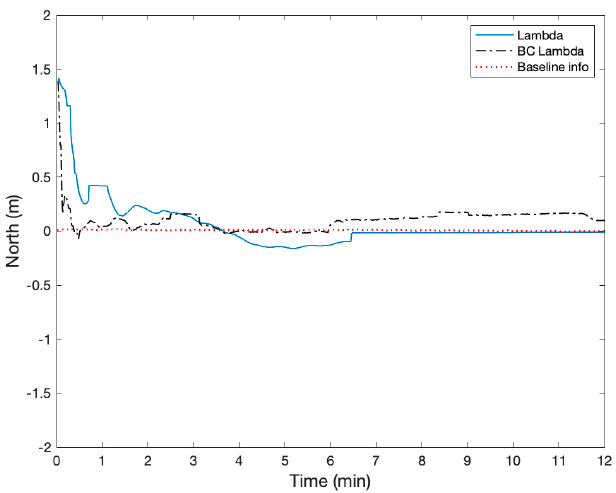
Figure 14. Comparison of the relative positioning error in the North using LAMBDA, Baseline Constrained (BC) LAMBDA, and the proposed method using baseline information.